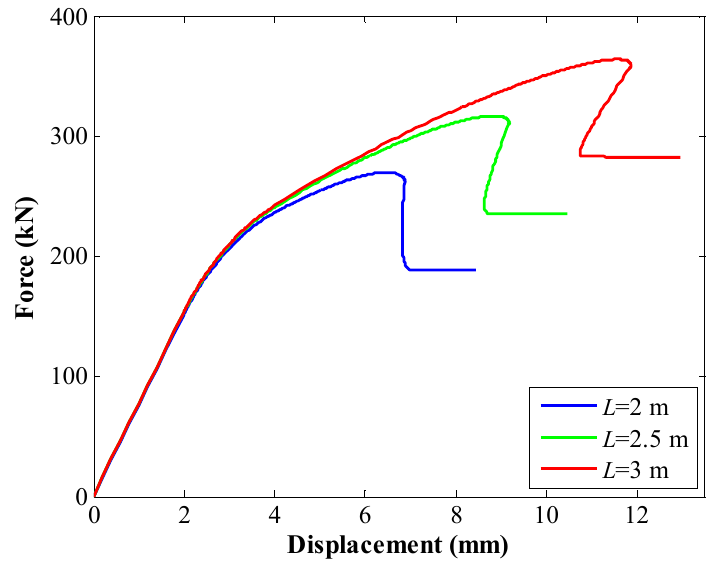
Figure 9. Effect of the grouting length on the load-carrying force of the bars.